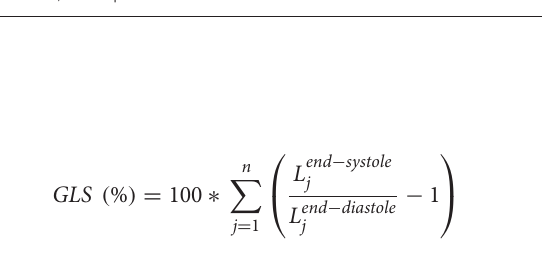
FIGURE 2 | Schematic representation of the orientation adjustment. A local coordinate system is defined for each mesh series, where the basis vectors correspond to the longitudinal (blue arrow), radial (red arrow), and anteroposterior directions (green arrow). First, the points of the septum–free wall boundary (red dots) are selected automatically from predefined groups of vertices so that they have a maximal local mean curvature. Then, a plane is fitted to the selected points using orthogonal distance regression (gray plane), and the radial basis vector is defined as the normal vector of this plane. The longitudinal basis vector should point from the apex ( v a ) toward the midpoint of the most basal vertex of the anterior and the most basal vertex of the posterior septum–free wall boundary ( p 1 + p m , where p 1 is the most basal vertex of the 2 anterior and p m is the most basal vertex of the posterior septum–free wall boundary). These two points are projected to the plane defined by the radial basis vector, and they are used to define the longitudinal basis vector. Finally, the anteroposterior basis vector can be determined using the other two basis vectors. See text for further details. The 3D right ventricular model is visualized from anteroseptal point of view. The surface of the mesh is color-coded based on the local mean curvature: yellowish colors indicate the most convex surface, whereas the deepest blue colors correspond to the most concave surface. AP,